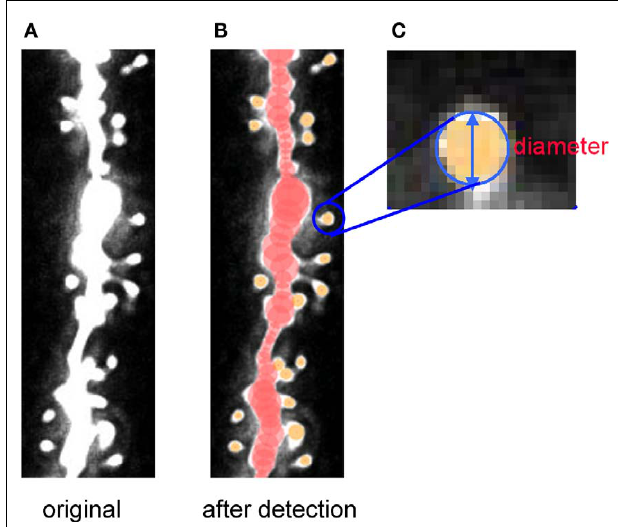
FIGURE 7 |Tracing of dendrites and detection of spines by Spiso-3D of confocal images. Spiso-3D detects spines by geometric calculation. (A) Original image of dendrite. (B) Traced dendrite (red circles) and spines (yellow circles) superimposed on the original image. (C) Calculated diameters of spines are superimposed on the original spine images. Modified from Mukai et al.